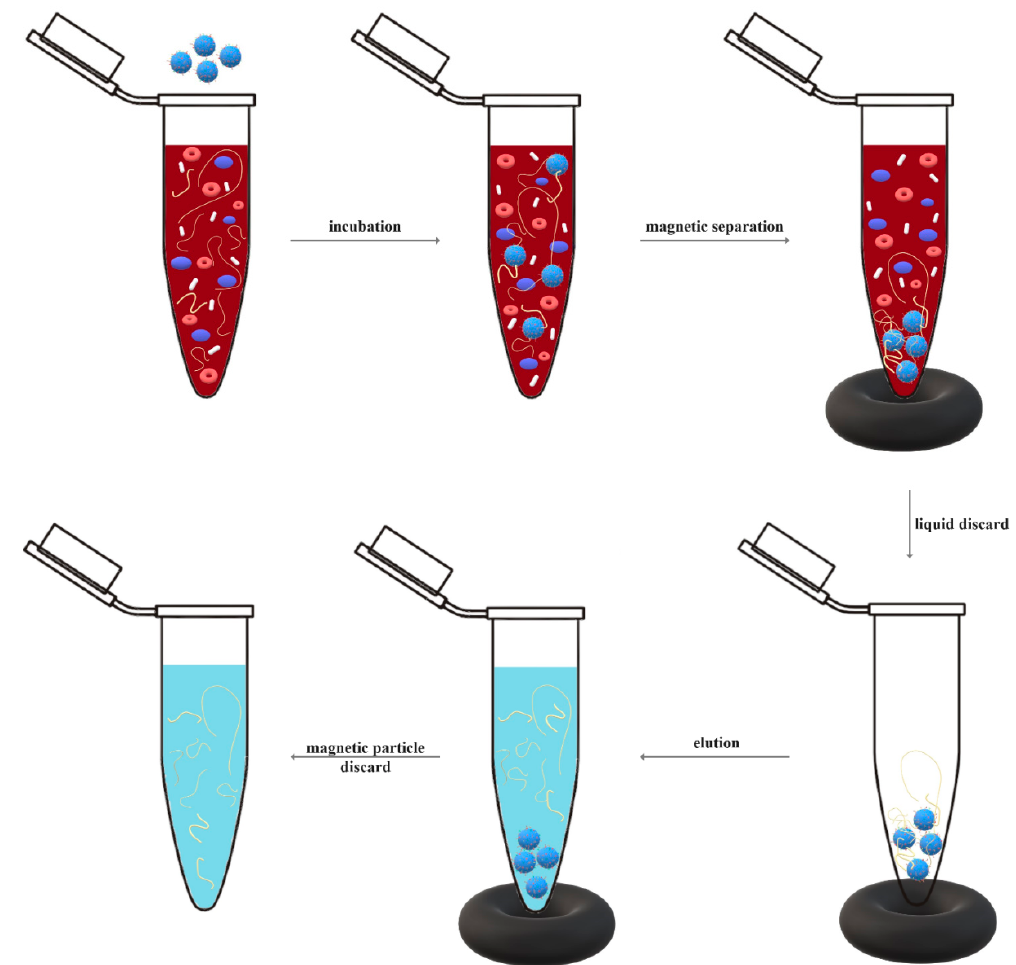
Figure 3. A schematic representation of the steps involved in magnetic